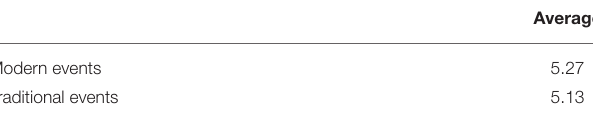
TABLE 3 | Impact of the event on the desire to lead an active lifestyle.